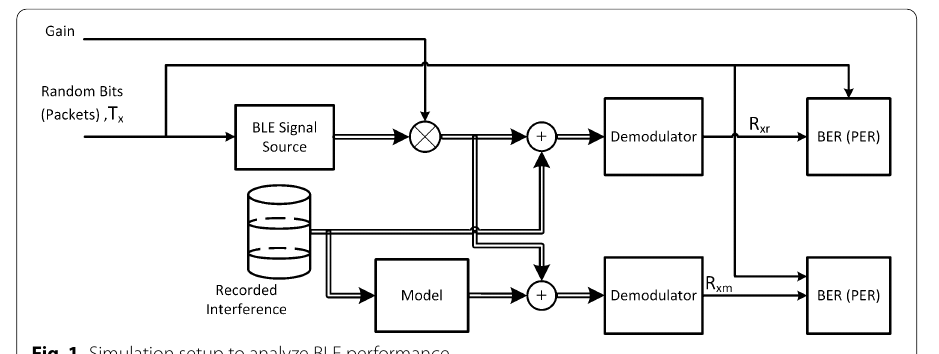
Fig. 1 Simulation setup to analyze BLE performance